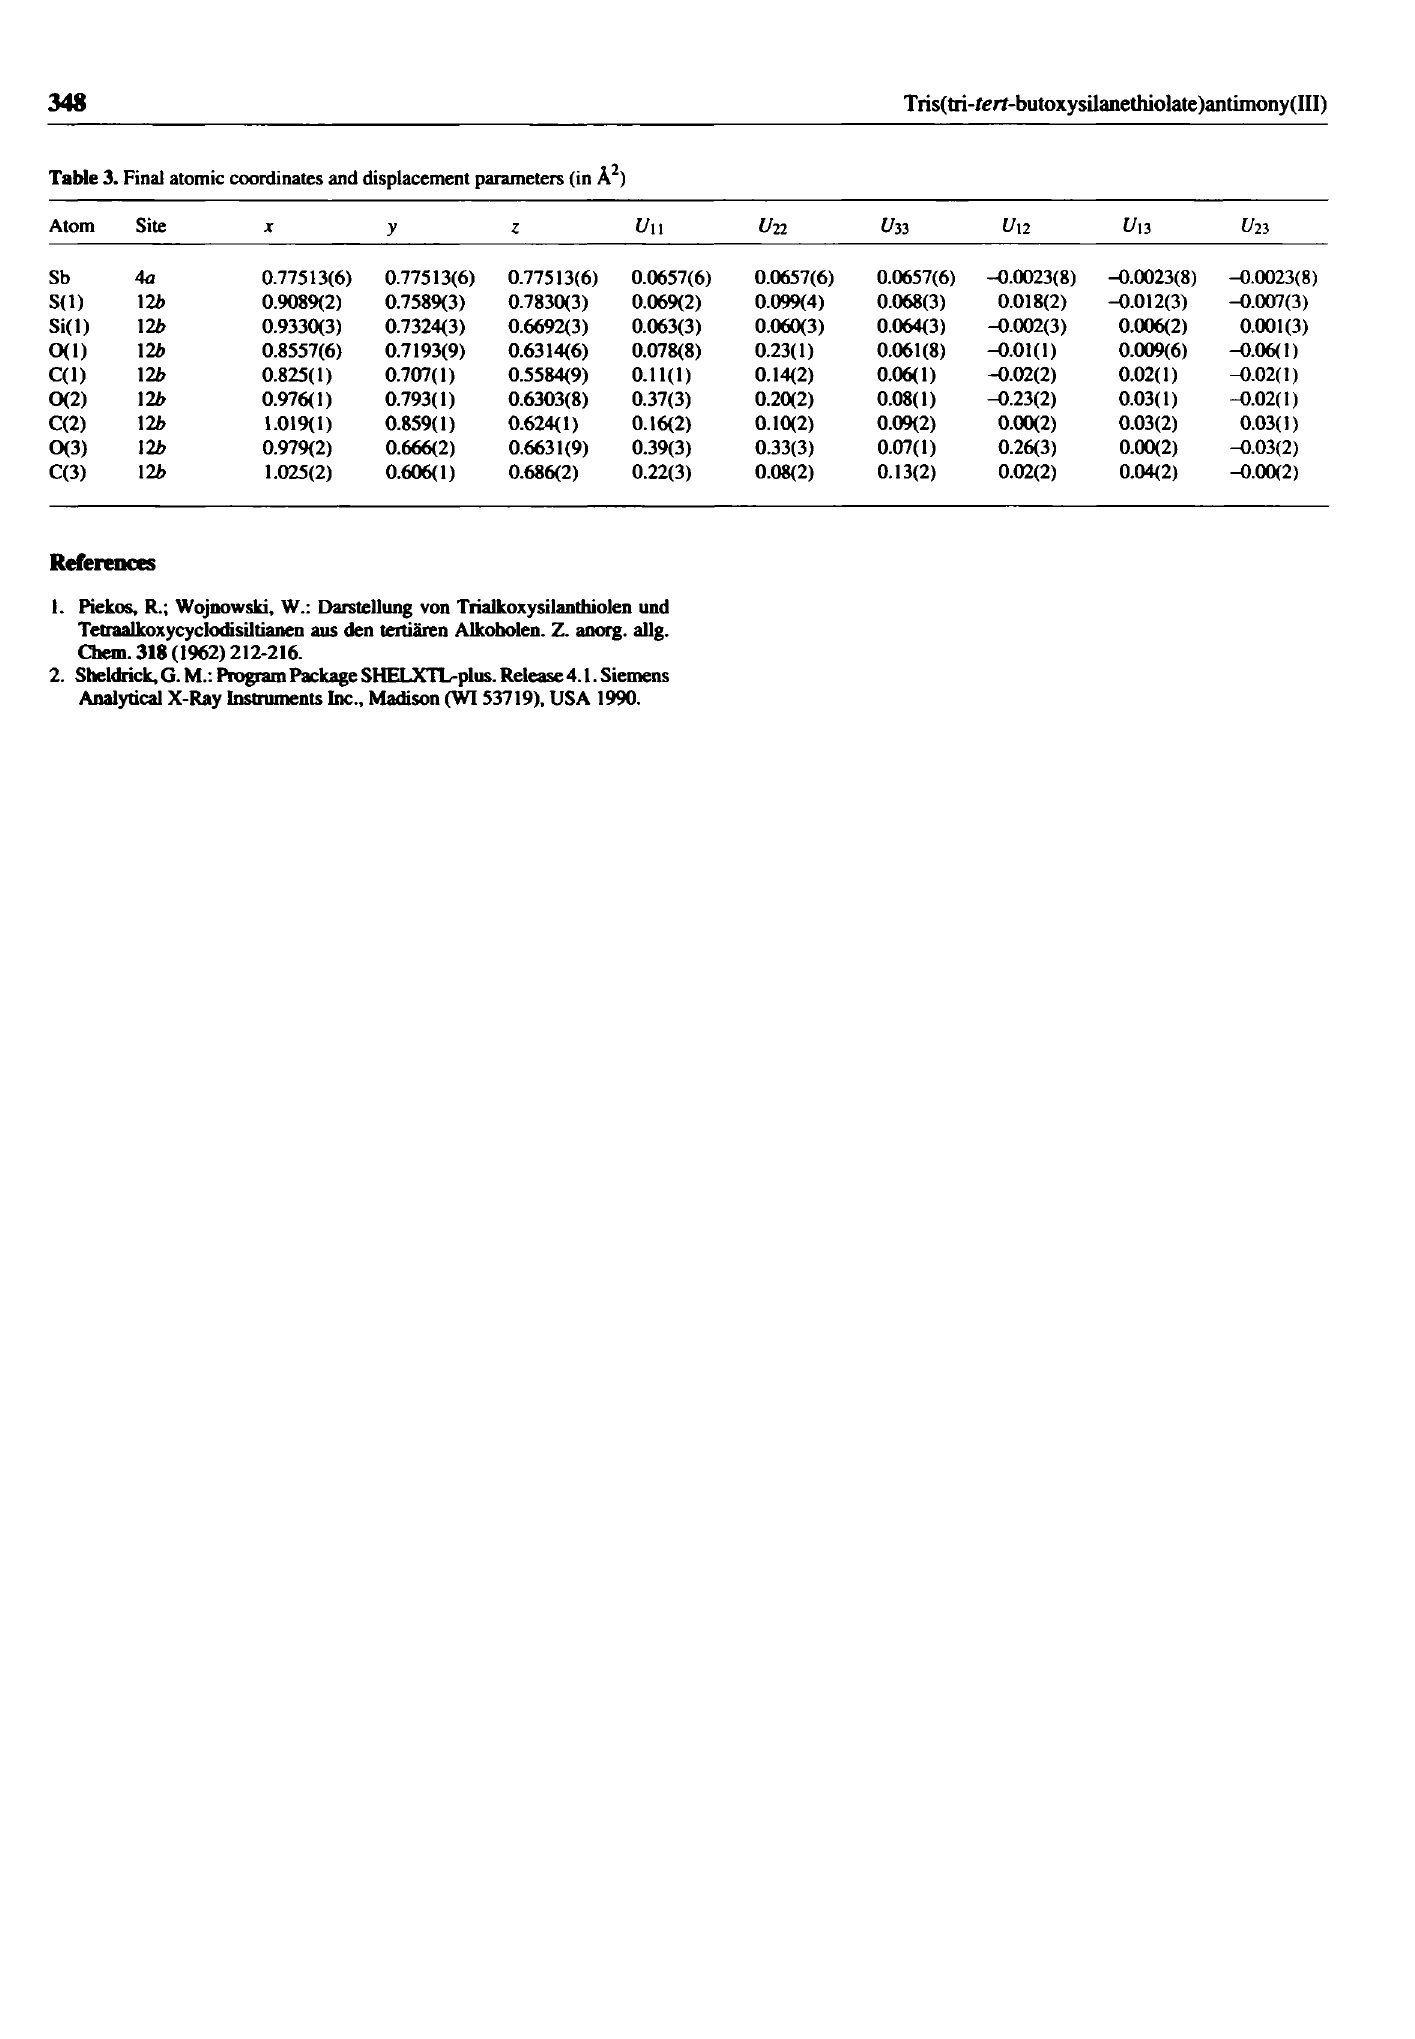
Table 3. Final atomic coordinates and displacement parameters (in Â 2